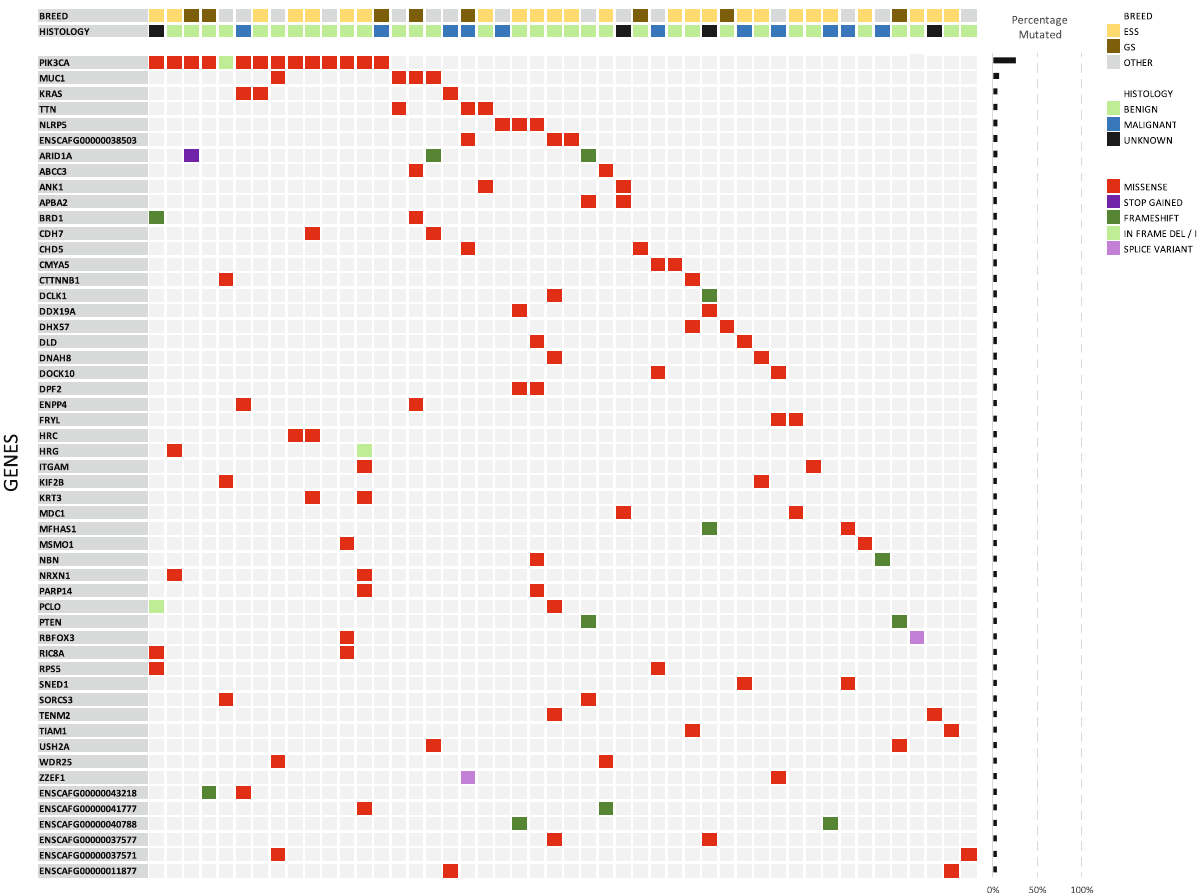
Figure 1. Waterfall plot showing the genes which were mutated in two or more tumors. Fifty-three genes were found to be mutated in more than one tumor sample. Only the fifty tumor samples with overlapping mutations are shown. Five tumors did not show any overlapping mutations and where excluded from the plot. The bar chart to the right illustrates the percentage of tumors carrying a mutation in a particular gene. The percentage is calculated relative to all 55 tumors in the